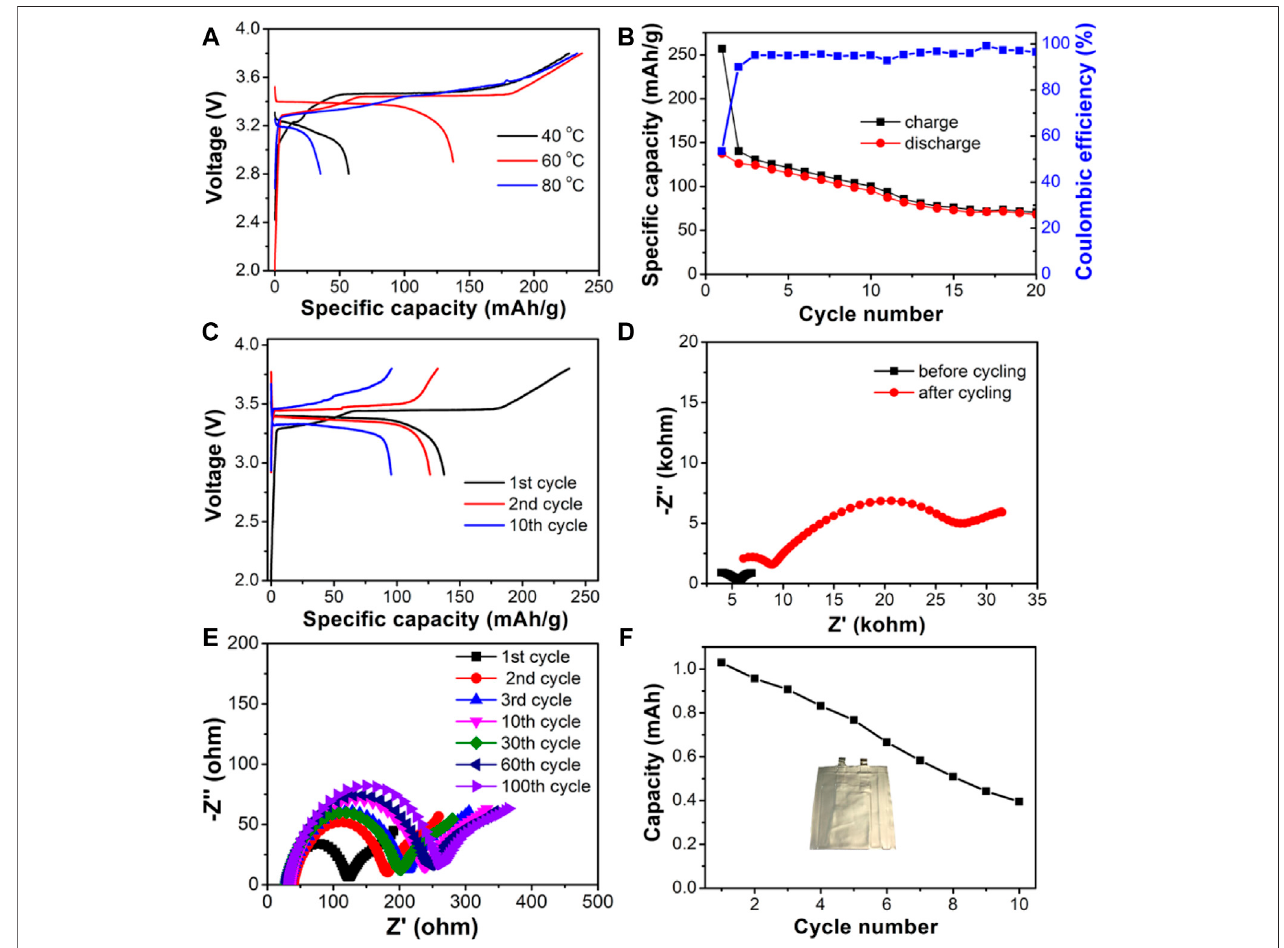
FIGURE 5 | (A – E) Electrochemical performance of Li/CPE/LiFePO (A) Voltage-capacity curve of the fi rst cycle at 4 coin cells based on the composite electrolyte. different temperatures. (B) Cycling performance at 60 ° C. (C) Voltage-capacity curve of different cycles at 60 ° C. (D) EIS plots of the SSLiB before and after cycling measured at 60 ° C. (E) EIS plots of the Li-Li symmetric cell running for different cycles. (F) Pouch cell performance.